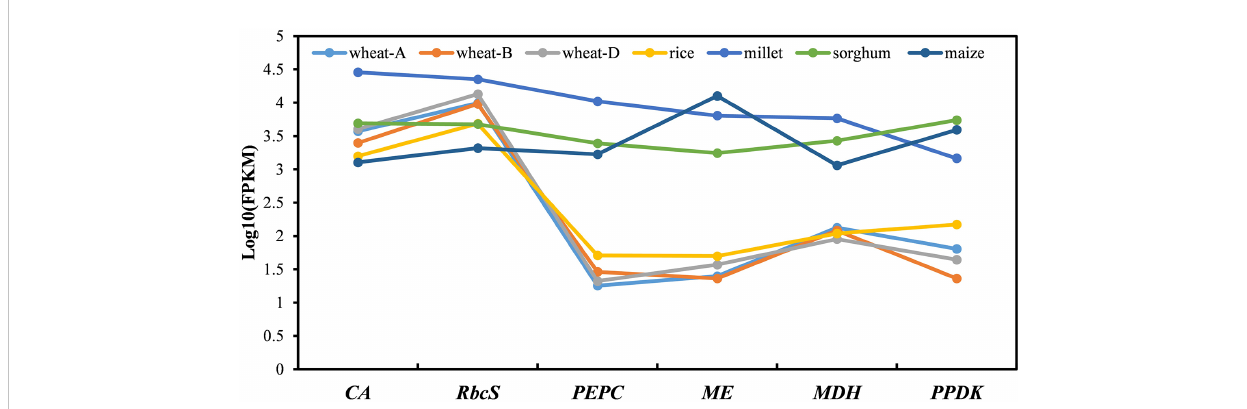
FIGURE 4 The expression synergy of the C 4 genes and C 4 orthologues in leaves of C 4 and C 3 species. The different coloured lines/dots represent the C 4 /C 4 - orthologues encoding six key enzymes in different gramineous crops. Wheat-A, wheat-B, and wheat-D represent three copies of the different subgenomes of bread wheat. Millet represents foxtail millet. The genes presented include b -CA3 , PEPC4 , ME4 , MDH3 , and PPDK1.1 orthologous groups, and the RbcS genes with the highest expression in each species. Because no PEPC4 orthologue was found in rice, the nearest paralogue, OsPEPC3 , was used